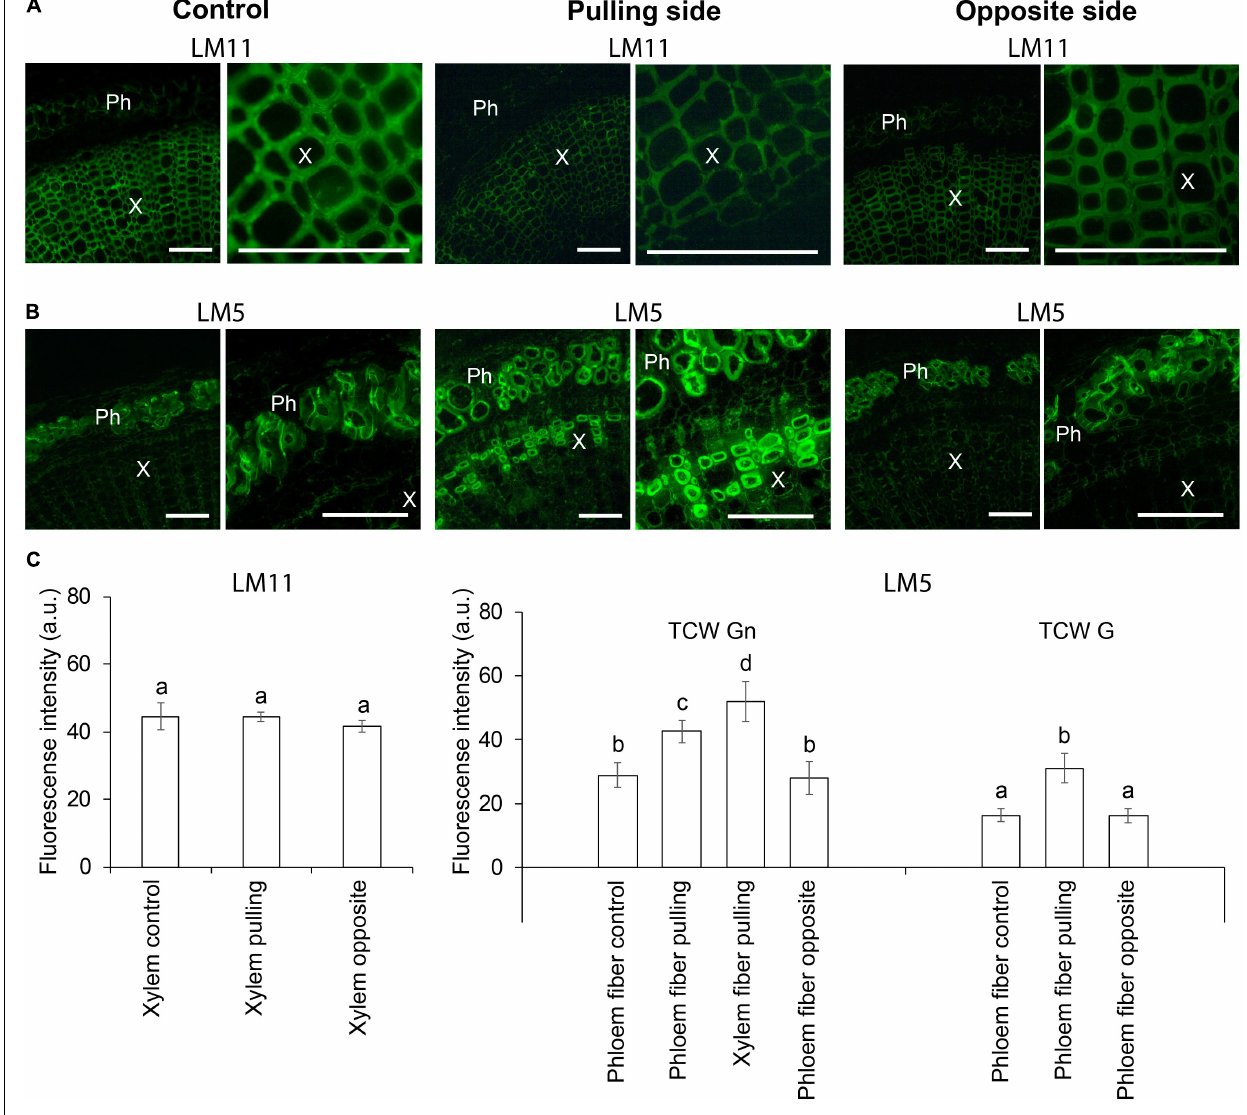
FIGURE 2 | Fluorescence micrographs of flax stem cross sections immunolabeled by (A) LM11 (xylan) and (B) LM5 (1,4-galactan) antibodies in control plants and after 4 days (96 h) of gravistimulation. Bars are 100 µ m. Ph, phloem; X, xylem. (C) Mean fluorescence intensity of different cell walls. TCW, tertiary cell wall; G and Gn, G and Gn layers. Values are the mean ± SD. Different letters above the bars indicate a significant difference according to one-way ANOVA followed by Tukey’s test at α =